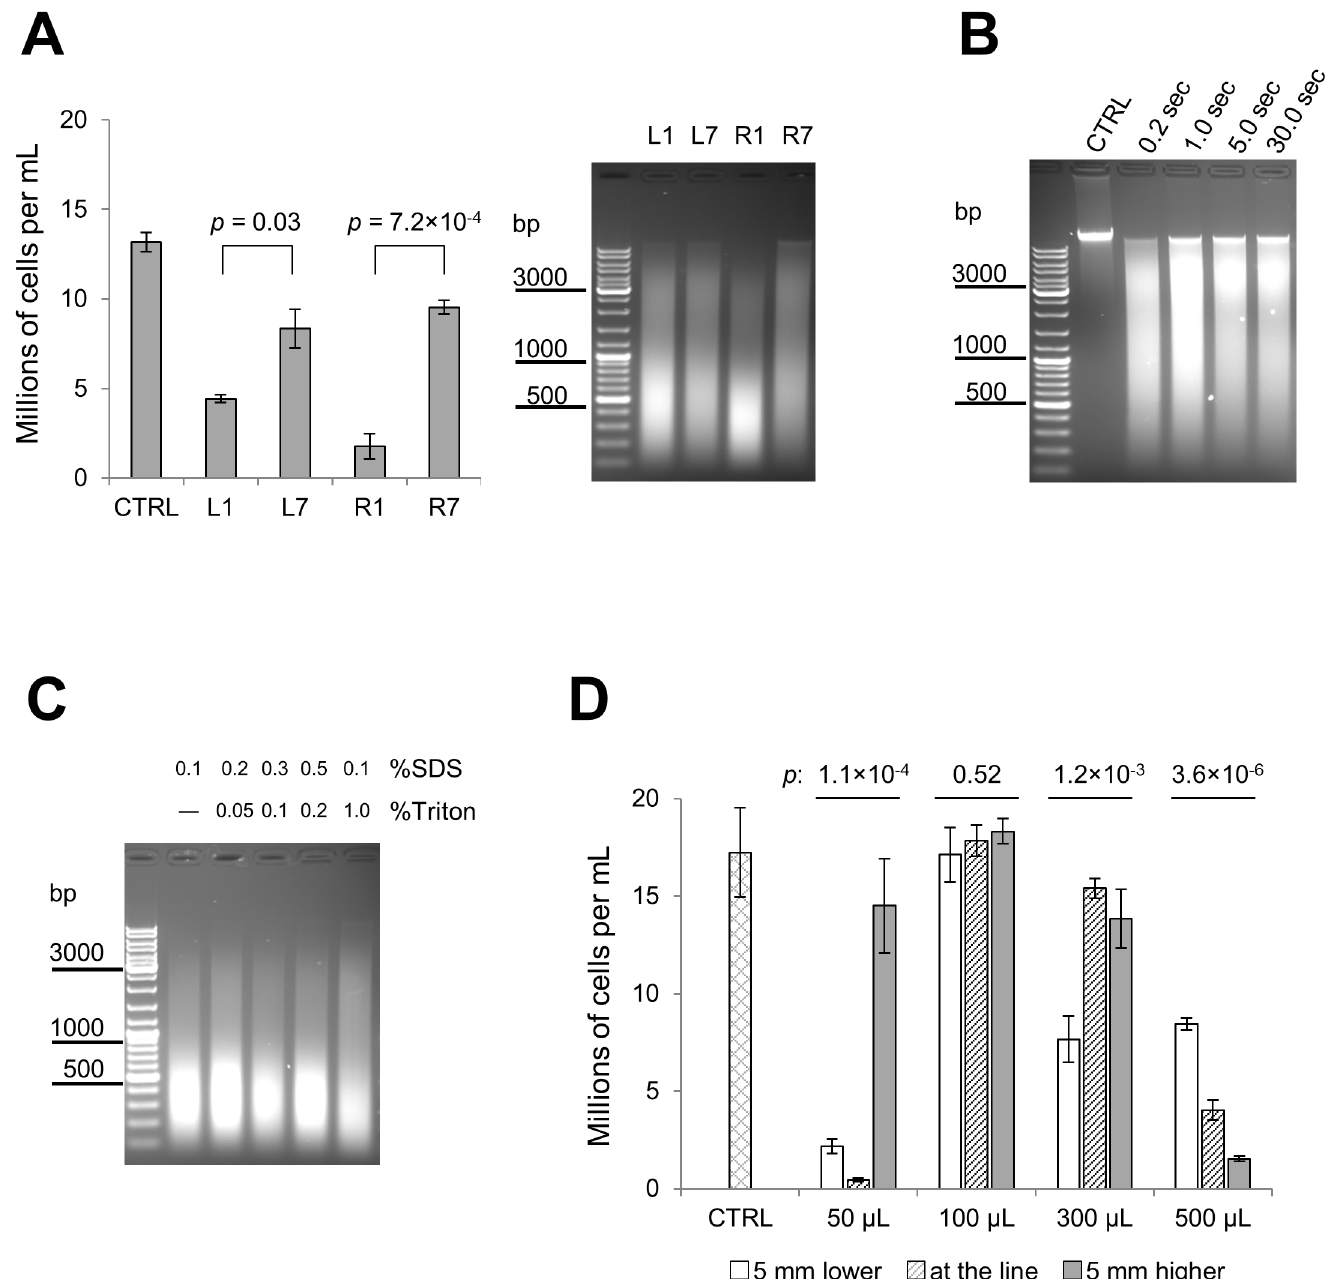
Fig 2. Systematic optimization of sonication conditions. Part 2. (A) The effect of sample position on sonication efficiency at low power setting. 500 μ L cell suspensions were loaded into positions L1, L7, R1, R7, all other positions were left vacant. Sonication was carried out for 1 min in 1:4 ELB:H 2 O (0.1% SDS final concentration), 5 sec ON/5 sec OFF pulses, no rotation, no ice. Left panel: Intact remaining cells were counted three times and the respective means calculated; error bars reflect the standard deviation. Right panel: Afterwards, the samples were sonicated for an additional 9 min and reverse cross- linked overnight. DNA was purified from the resulting mixture using the Qiagen PCR clean-up kit and analysed on 1.1% agarose gel. The control (CTRL) sample is the cell suspension before sonication. p -value for analysis of variance between sonicated samples is 1.0×10 − 5 . p -values for selected T-tests are shown on the graph. (B) The effect of pulse time on sonication efficiency. 500 μ L cell suspensions were loaded into position R1; vacant R-positions were filled with tubes containing 500 μ L of water. Sonication was carried out for 2 min in 1:4 ELB:H 2 O (0.1% SDS final concentration), with variable pulse times (as indicated), no rotation and no ice. Following sonication, samples were reverse cross-linked overnight. DNA was purified from the resulting mixture using the Qiagen PCR clean-up kit and analysed on 1.1% agarose gel. The control (CTRL) sample is the cell suspension before sonication. (C) The effect of buffer composition on sonication efficiency. 500 μ L cell suspensions were loaded into position R1; positions R4, R7 and R11 were filled with tubes containing 500 μ L of water; other R-positions were left vacant. Sonication was carried out for 10 min in 1:4 ELB:H 2 O supplemented with varying concentrations of SDS